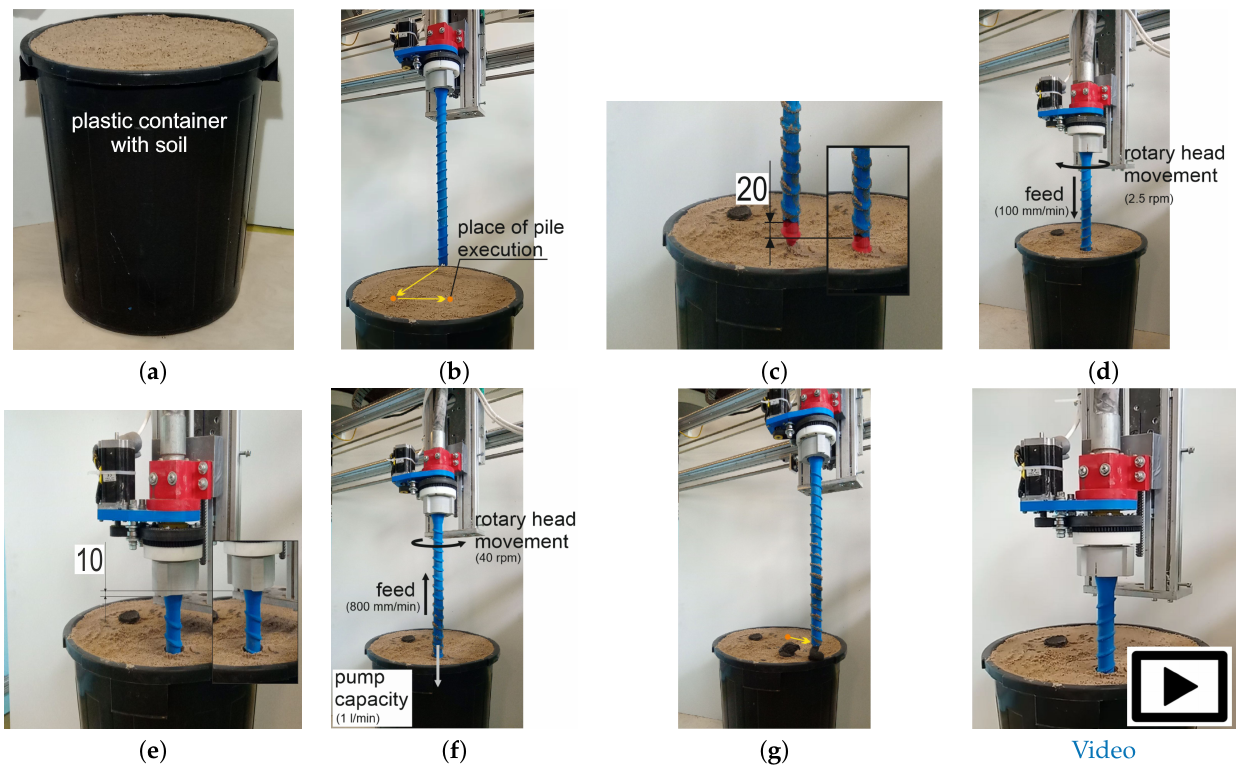
Figure 11. Stages of performing a foundation pile: ( a ) Stage 1—Preparing the soil in the container, ( b ) Stage 2—positioning the printer over the place of performing the pile, ( c ) Stage 3—assembling the plug and pressing it to the soil, ( d ) Stage 4—immersing the drill, ( e ) Stage 5—disconnecting the drill and the plug, ( f ) Stage 6—forming the foundation pile, and ( g ) Stage 7—finishing the work. Video: See Supplementary